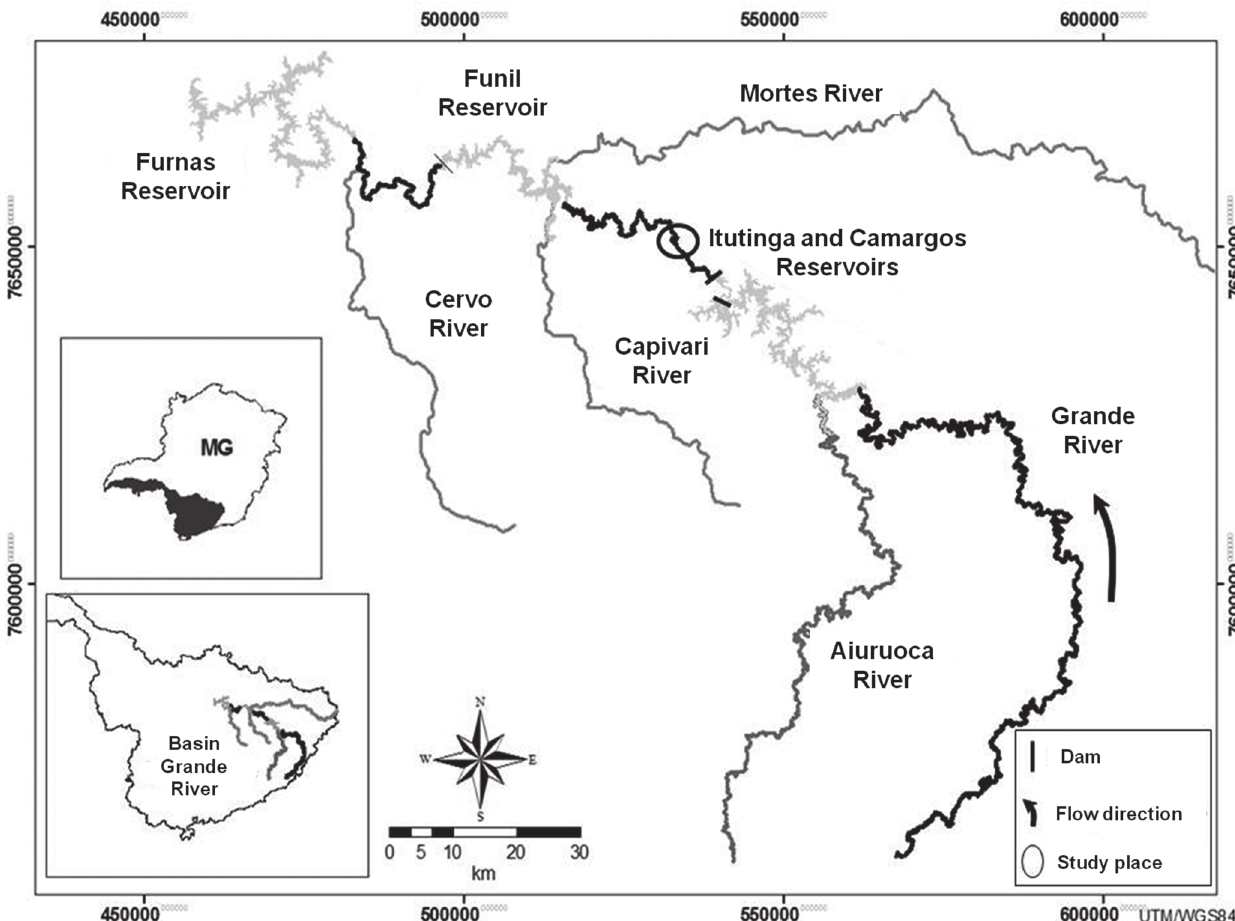
Fig. 1. Schematic drawing of the Grande River basin upstream from Furnas Reservoir. The study area is highlighted by a black